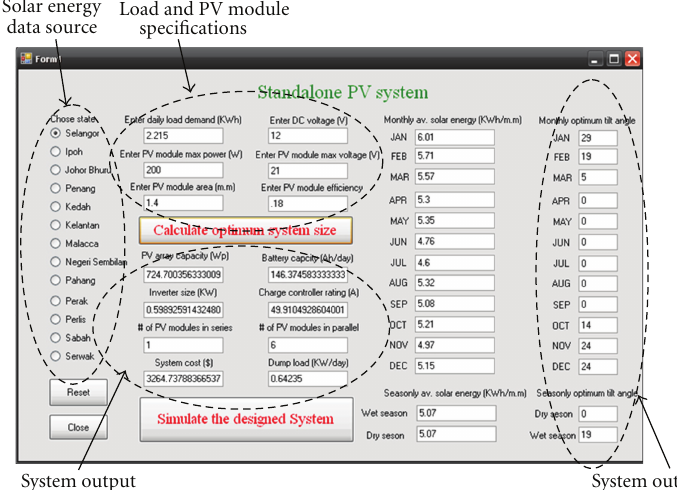
Figure 11: Output display of the GUI for designing standalone PV